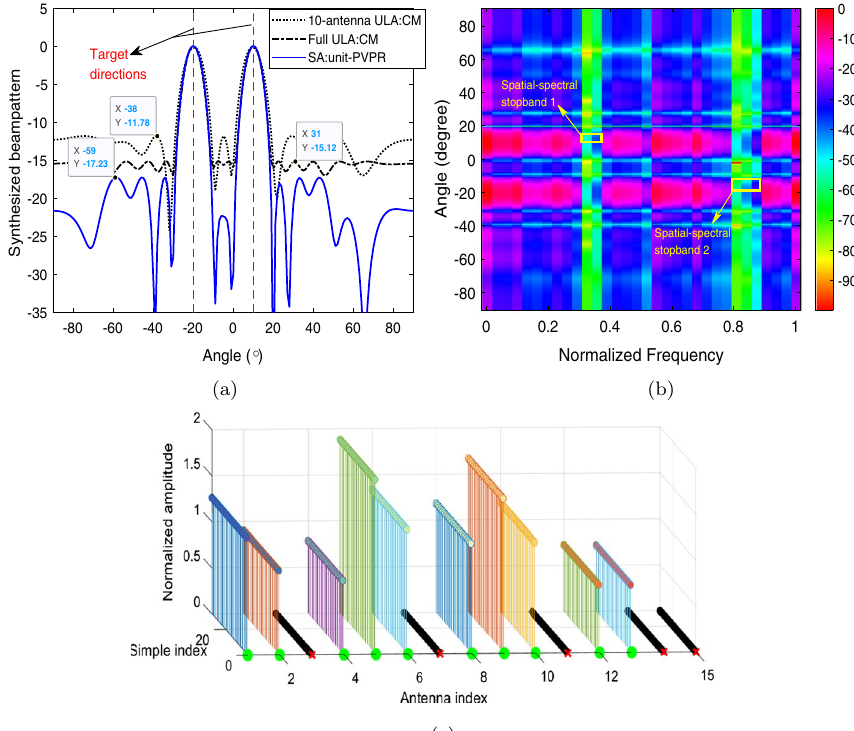
Fig. 11 a Synthesized beampatterns in example 4; b Energy distribution in the spatial–spectral domain under the proposed SA with unit-PVPR constraint; c Normalized waveform amplitude distribution and selected antenna locations of the proposed